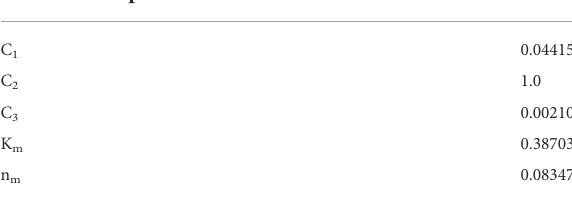
TABLE 3 Modi fi ed Mohr-Coulomb fracture model